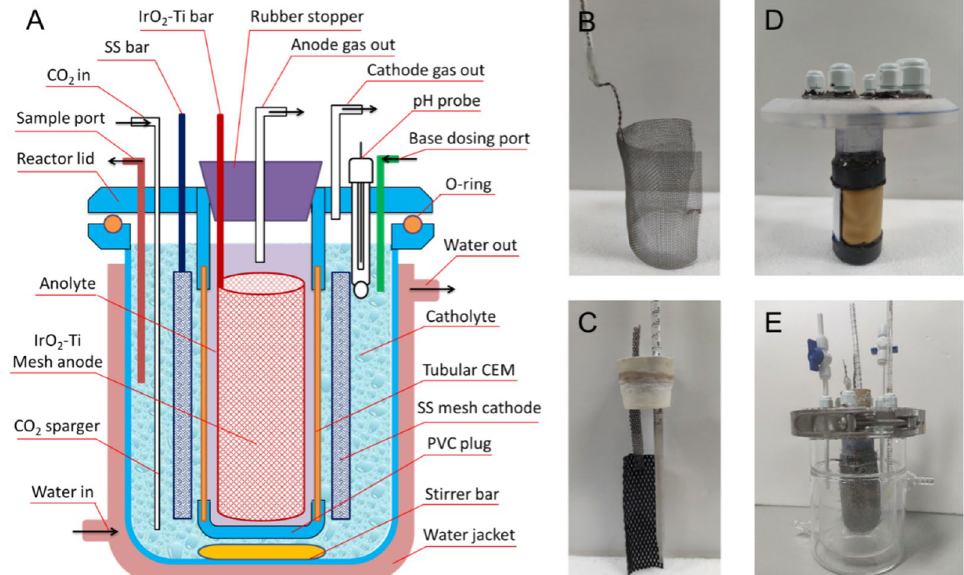
Fig. 2 The schematic of the E-CSTR reactor ( A) and photos of the reactor parts ( B : the cathode; C : the anode; D : the anode membrane assembly; E : the jacketed mixing